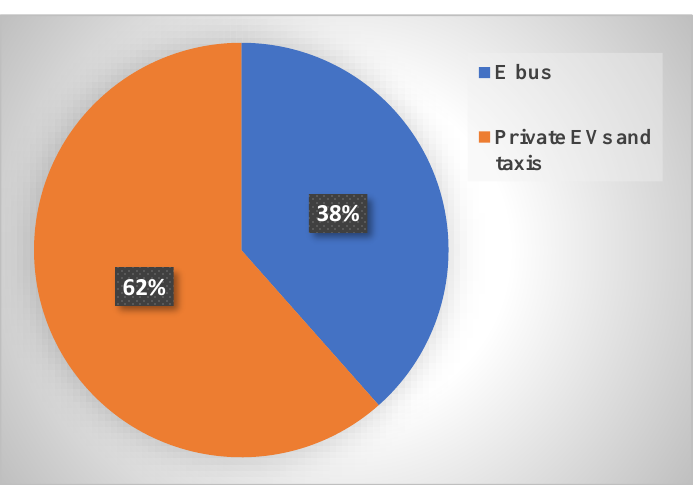
Figure 1. Quantitative analysis of reported research works on charging demand prediction.